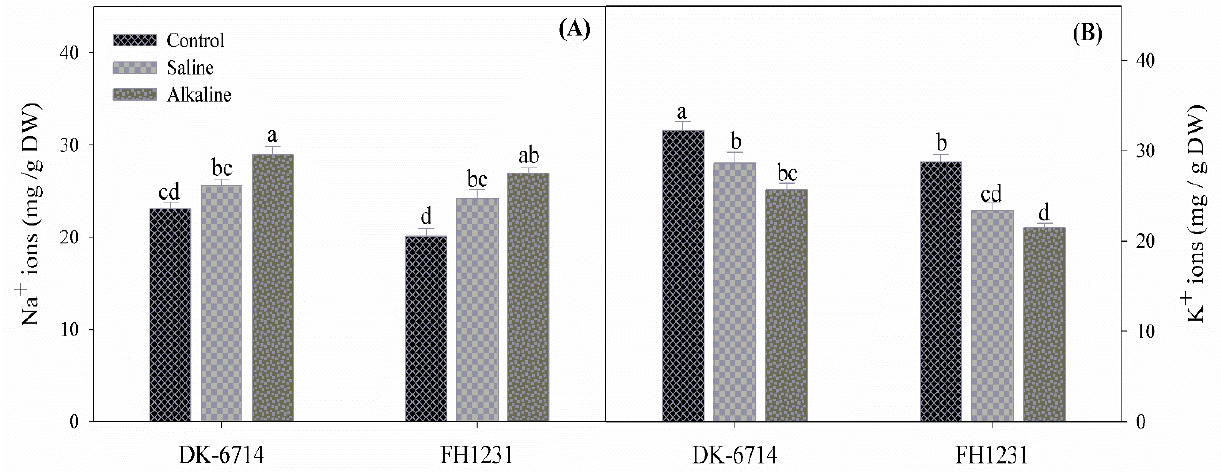
Figure 4. Effect of salinity and alkalinity stress on ( A ) Na+ ions and ( B ) K+ ions in 20-day-old maize seedlings of two hybrids (DK-6714 and FH-1231). The bars represent the standard error (SE) of the four replicates. Similar small letters above bars represent nonsignificant (ns) differences among treatments ( p ≤ 0.05).